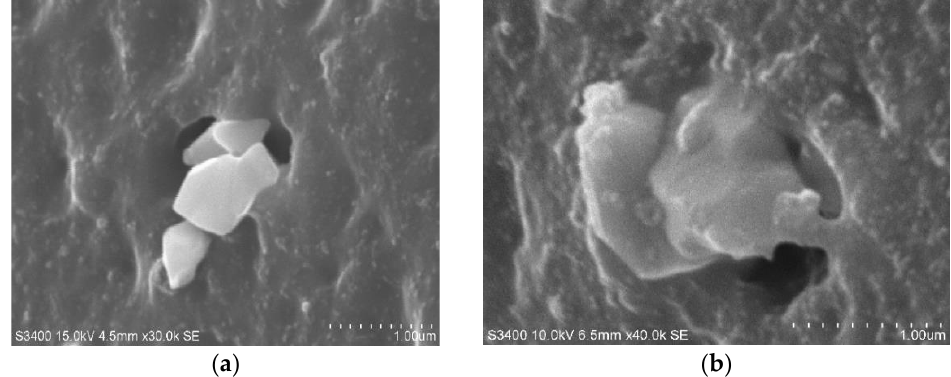
Figure 1. SEM photograph of silica-NR compound ( a ) without silane, ( b ) with silane (TESPT) [6]. Additionally, the smart processing of polymer composites improves the construction of polymer composites, which is influenced by the choice of mixers, processing condition, processing technique, use of a 3D printer, etc. These include the mixing mechanisms [mixer (internal/open), intermeshing/tangential type (rotor type and screw configuration), reactive mixing (temperature/speed at each stage, curing condition (pre/post), mixing sequence, mold design and molding technique (filler orientation, simulation, pre-treatment (chemical, thermal . . . )) etc.] [4,5,9–13]. These contribute to the construction of advanced polymer composites for high-performance automotive and aerospace parts, advanced electronic devices, environmentally friendly goods, sensors, and other such